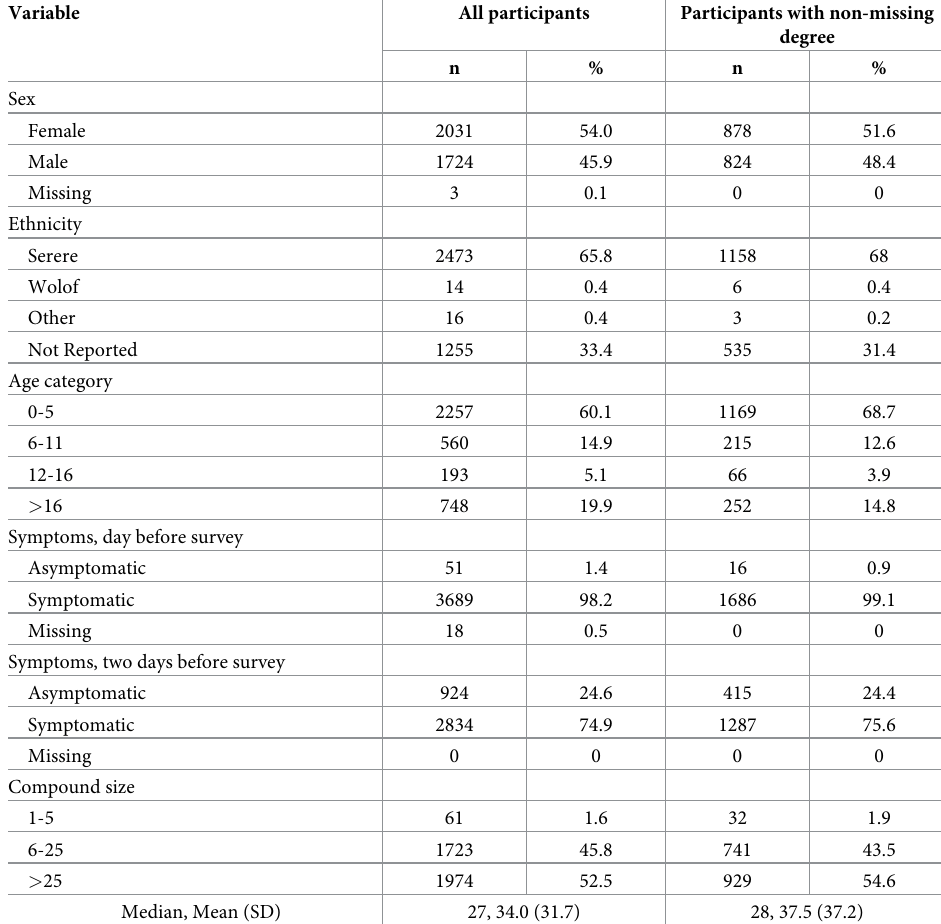
Table 1. Distribution of sex, ethnicity, age, compound size, and symptom status for (1) all participants completing a survey between August 1, 2009 to February 1, 2010 and (2) all participants who contributed to the complete-case analysis. Variable All participants Participants with non-missing